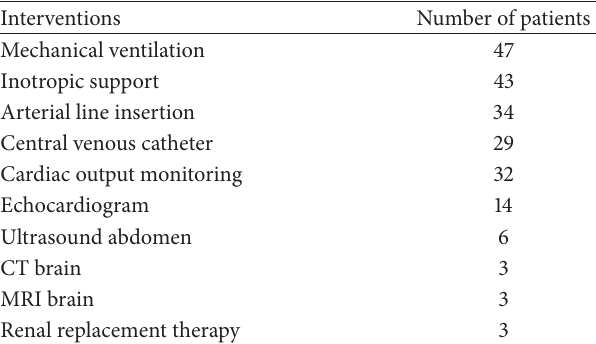
Table 4: Interventions undertaken in obstetric patients admitted to intensive care